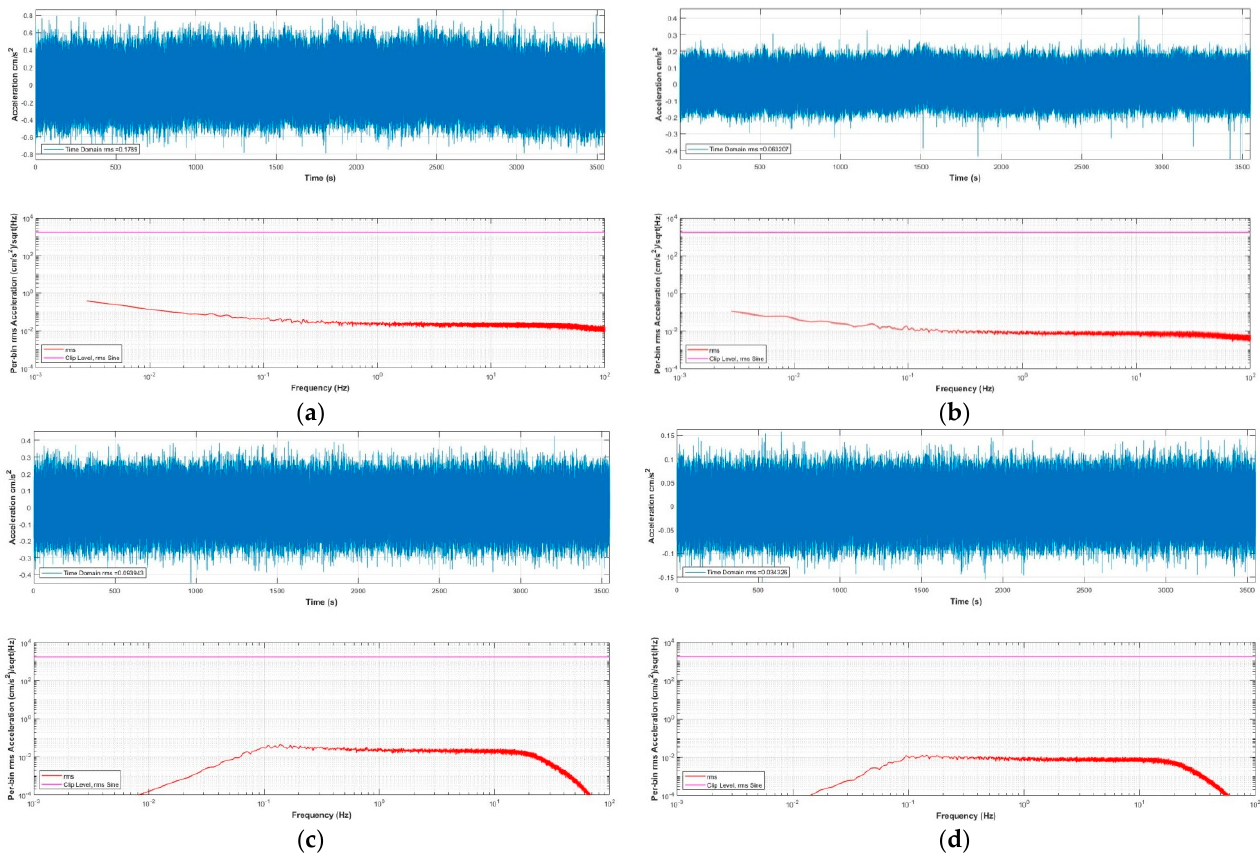
Figure 8. Instrumental noise recording and the spectral density, sampling rate 200 Hz. ( a ) Unfiltered noise, single sensor acquisition; ( b ) unfiltered noise, with eight sensors arranged for parallel acquisition; ( c) noise with single sensor acquisition, filtered by 0.1–20 Hz bandpass; and ( d ) noise with eight sensors arranged for parallel acquisition, filtered by 0.1–20 Hz bandpass.